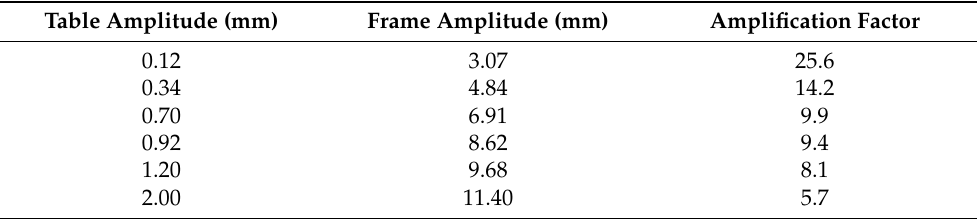
Table 2. Amplification factor as the ratio of the amplitude of the frame top and the amplitude of the shaking table.